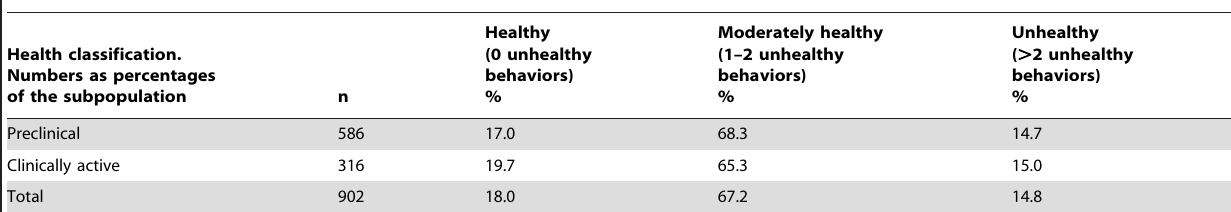
Table 3. Classification of students based on summed health score.